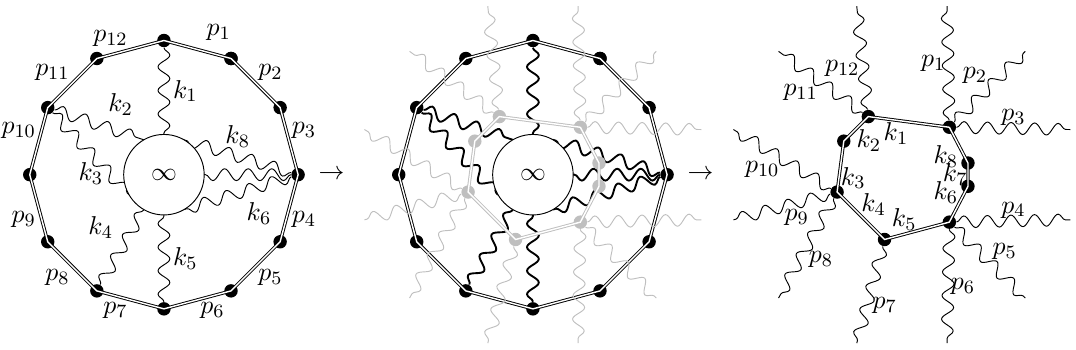
Figure 3 . The left figure represents a planar Born-level diagram for the Wilson loop form factor W (0 , 0) . The external particles are coming from infinity which is chosen inside the Wilson loop 12 , 8 contour. The right figure represents a diagram for W (0 , 0) where the variables specifying the Wilson 8 , 12 loop contour and the external particles are swapped. Here infinity is chosen to lie outside the Wilson loop contour. In the middle figure the two diagrams are superimposed so that the planar graph duality is